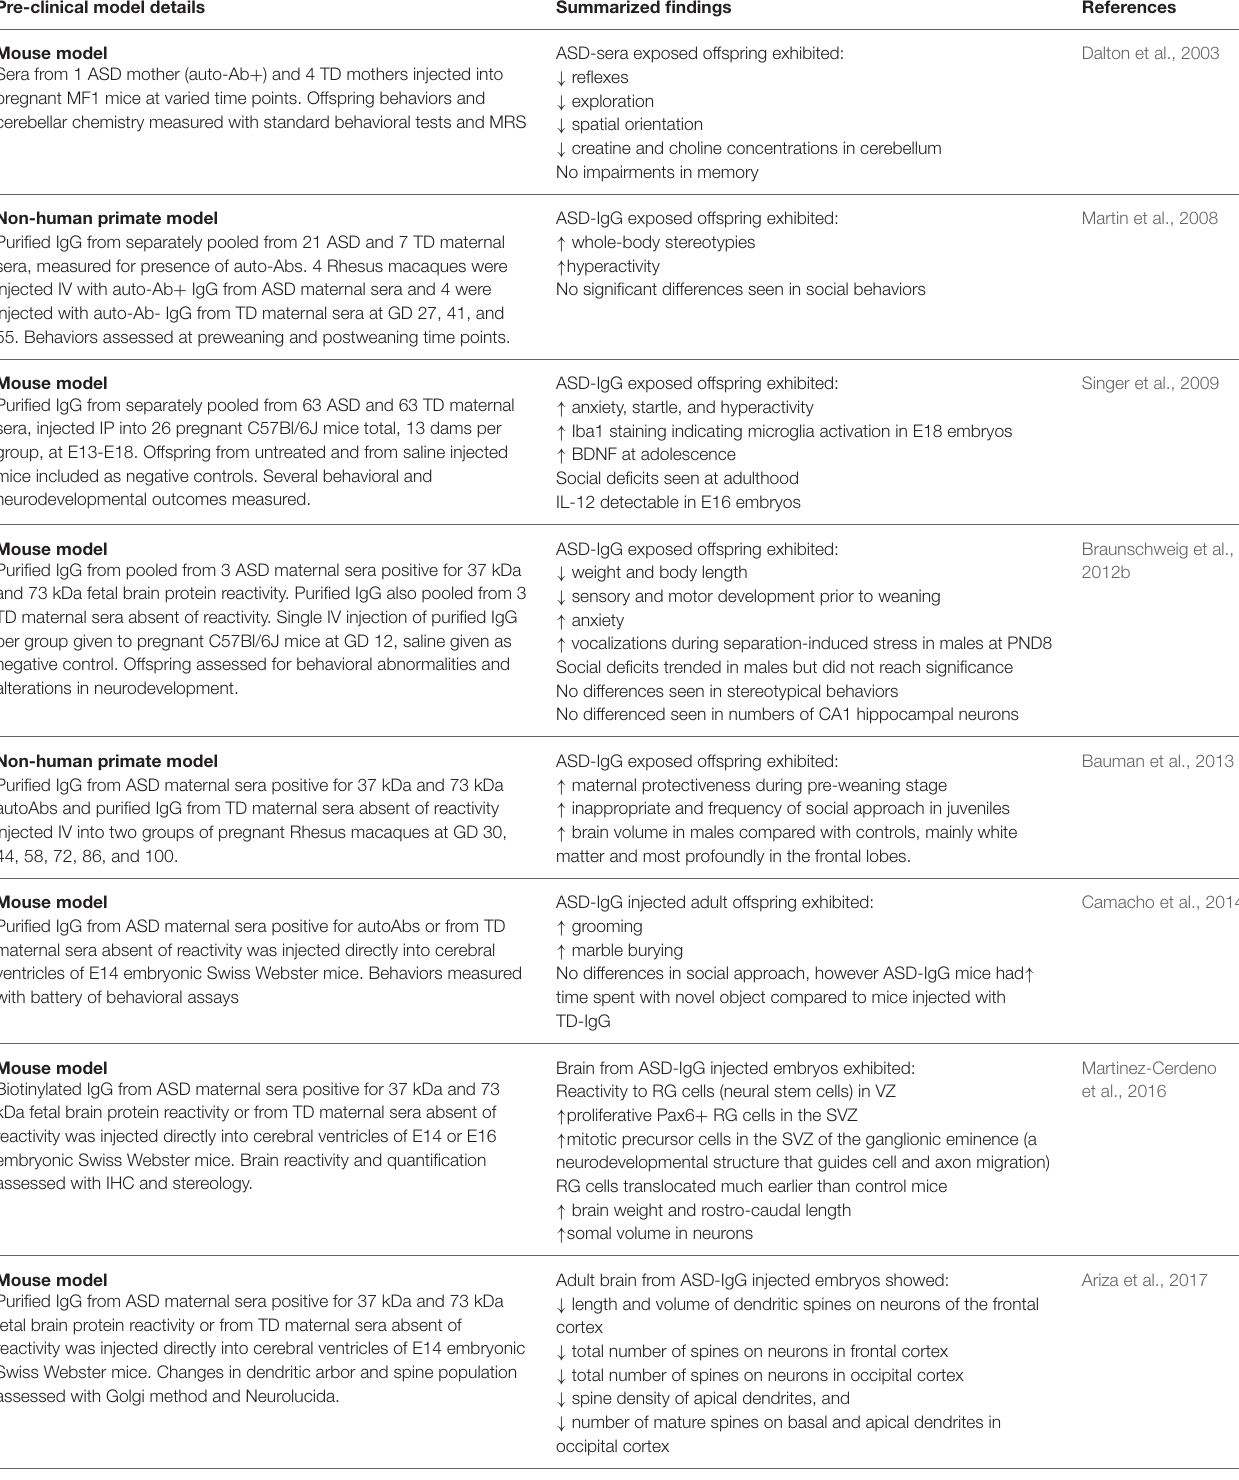
TABLE 3 | Preclinical studies of maternal autoantibodies and ASD-like